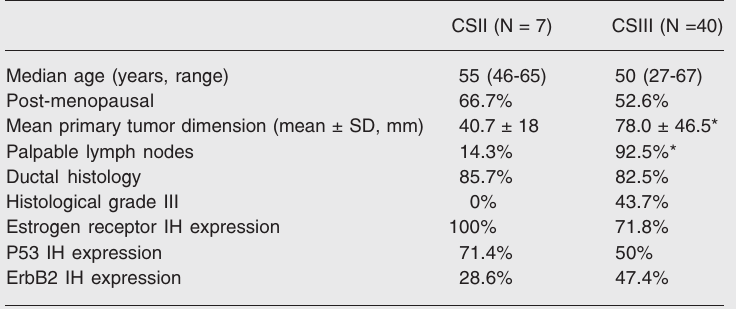
Table 1. Breast cancer patient